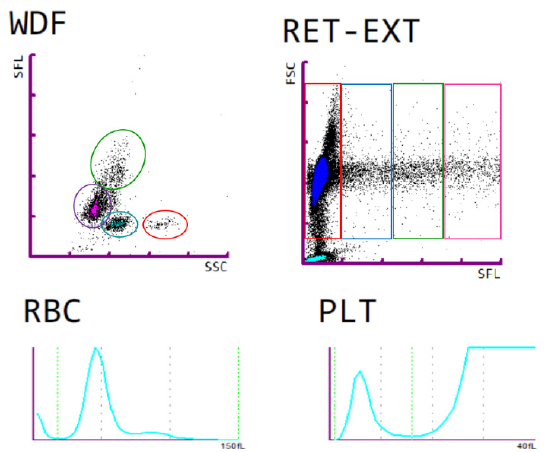
Table 1. Plasma analysis of wild type (WT) and PACAP heterozygous (HZ) mice. Results are given